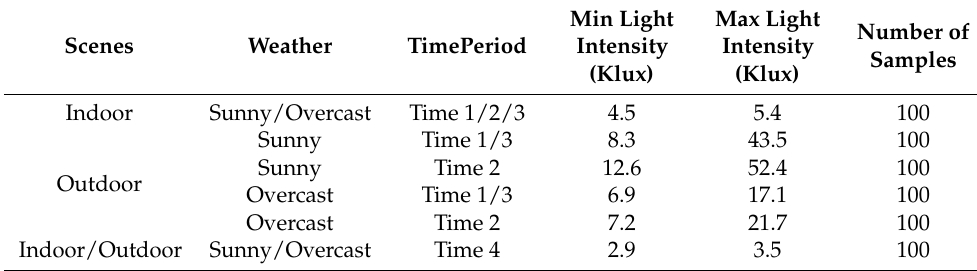
Table 2. Data information in the aiming